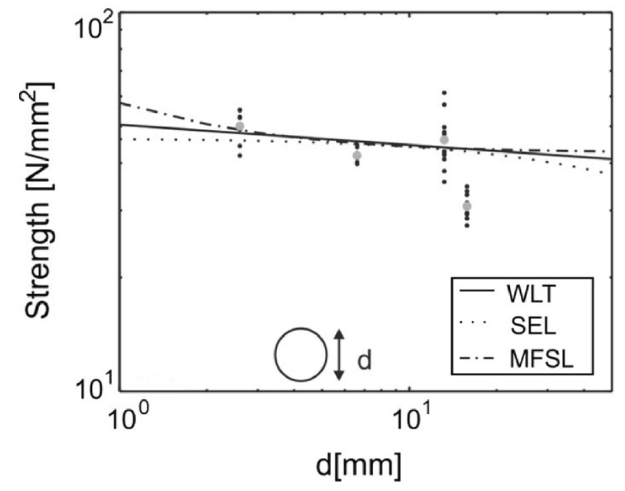
Figure 31. Plot of the effect of specimen size on compression strength. Comparison is made for three different theories. WLT means ‘weakest link theory’; SEL means ‘size effect law’, MFSL means ‘mul- tifractal scaling law’. From [125].